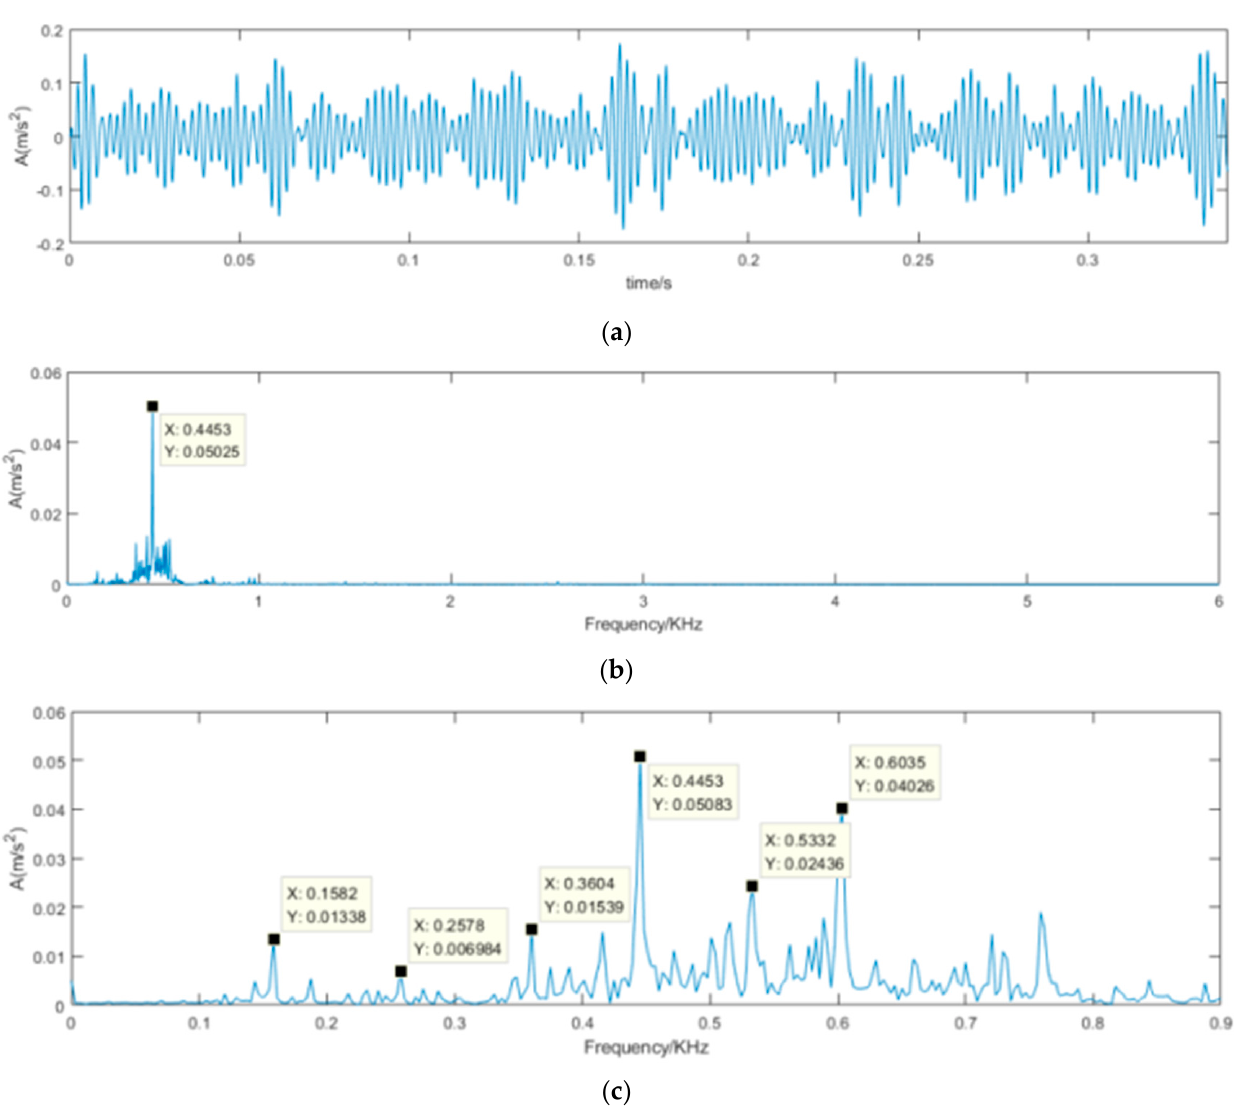
Figure 10. Time-domain waveform and frequency spectrum of denoised signal using SVD-VMD. ( a ) Time-domain waveform of denoised signal using SVD-VMD; ( b ) Frequency spectrum of de- noised signal using SVD-VMD; ( c ) Frequency spectrum limited in 0.9 KHz of denoised signal using SVD-VMD.